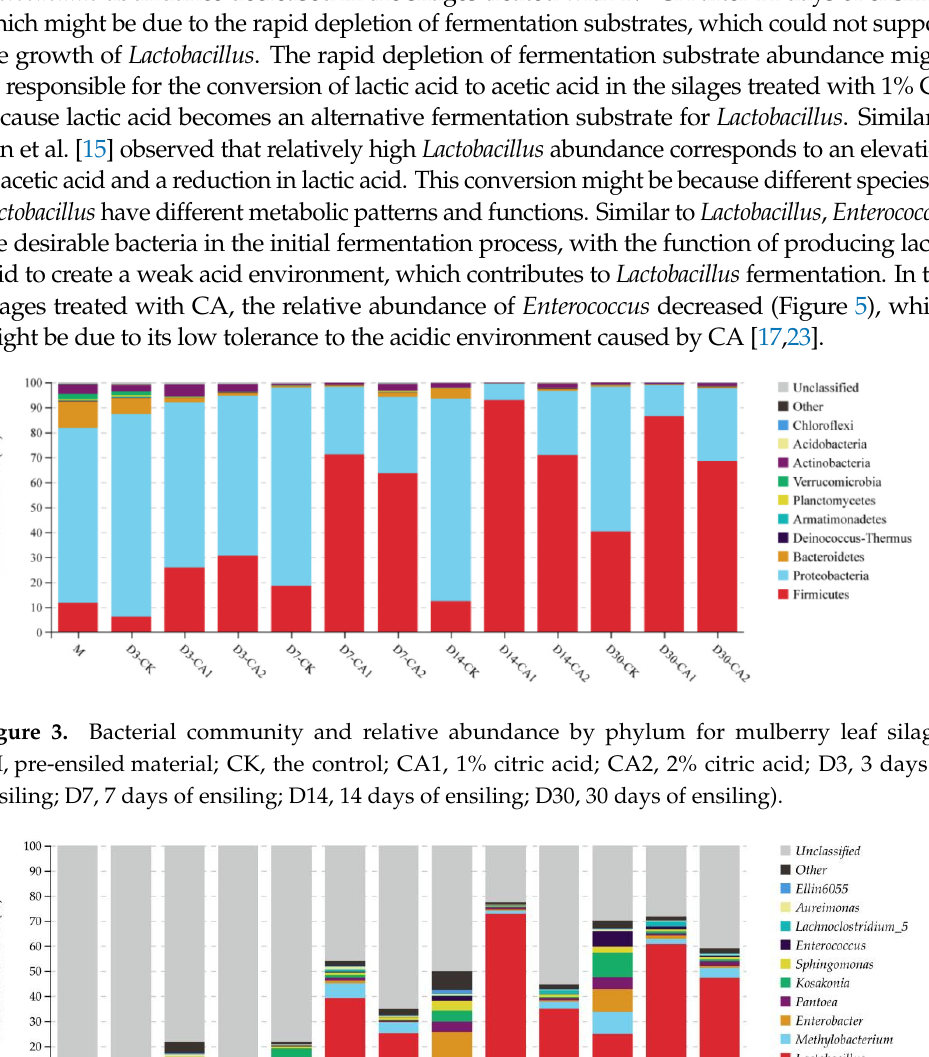
Figure 5. Heatmap of prominent bacterial genera (20 most abundant genera) for mulberry leaf si- lages (M, pre − ensiled material; CK, the control; CA1, 1% citric acid; CA2, 2% citric acid; D3, 3 days of ensiling; D7, 7 days of ensiling; D14, 14 days of ensiling; D30, 30 days of ensiling). 3.5.3. 16S rDNA Gene-predicted Functional Profiles The 16S rDNA gene-predicted functional profiles are shown in Figure 6. CA inhibited the metabolism of energy, carbohydrate, folding, sorting and degradation, and membrane transport, which might be attributed to CA decreasing the pH value and inhibiting micro-